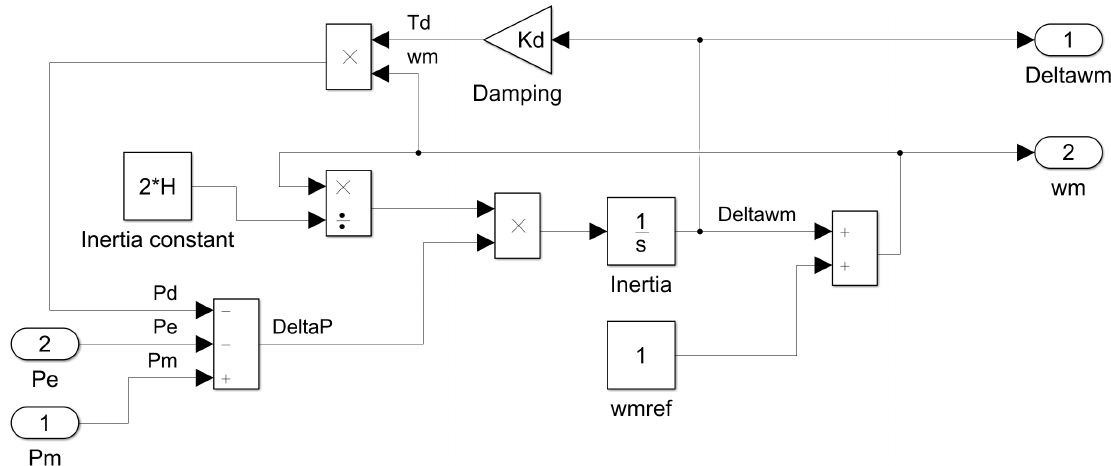
Figure 7. Simplified model of the HES as a